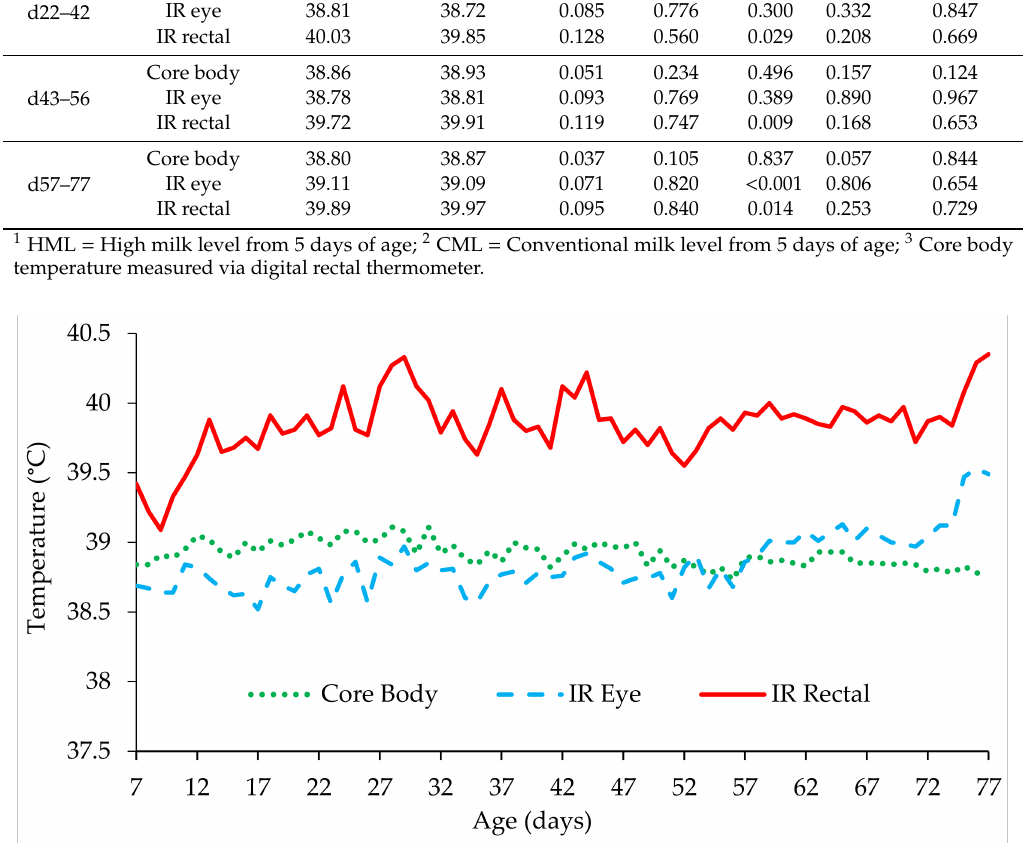
Figure 1. Core body temperature as measured via digital rectal thermometer, IR eye and IR rectal temperature of calves between 7 to 77 days of